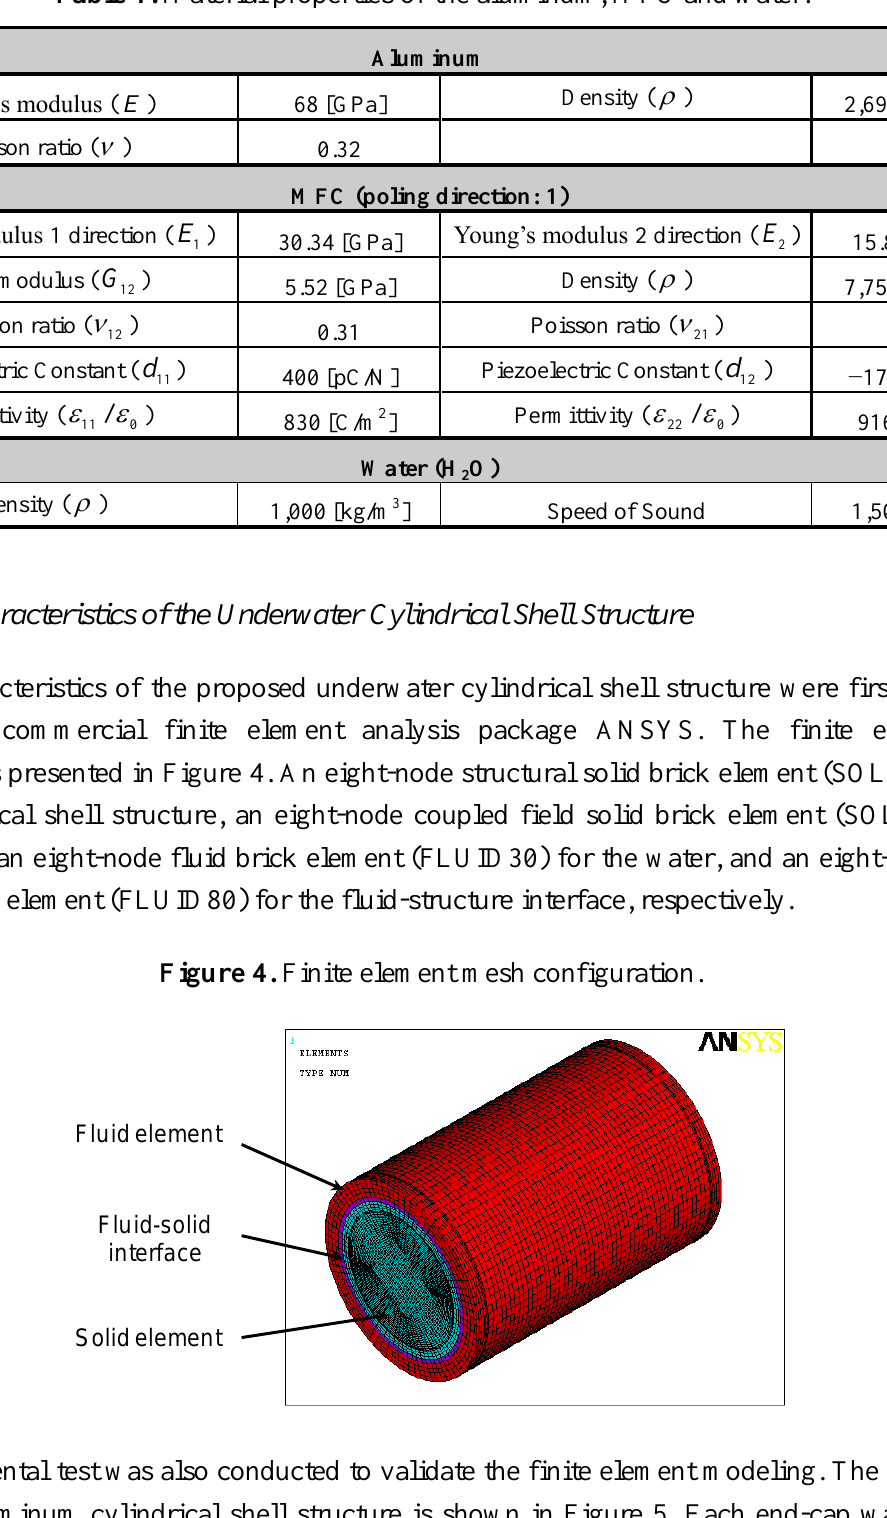
Table 1. Material properties of the aluminum, MFC and water.